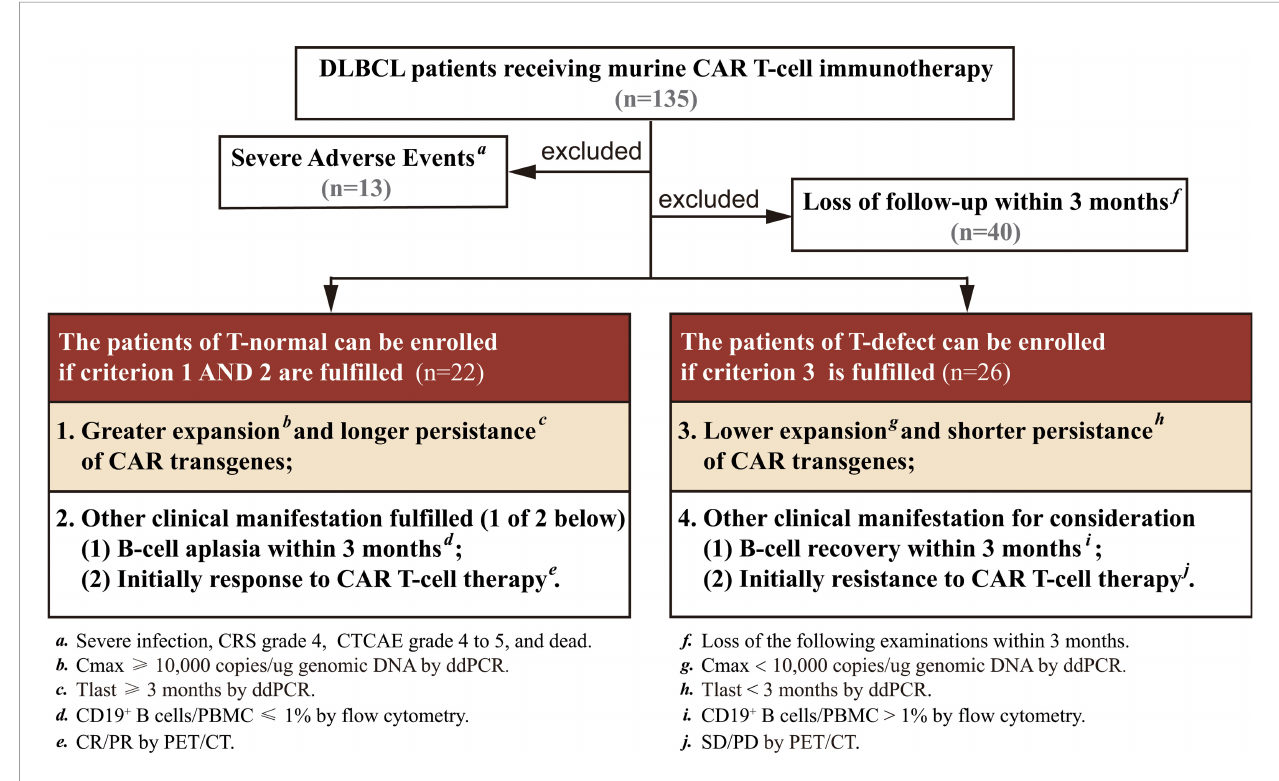
FIGURE 1 | Flow diagram summarizing patient recruitment, exclusion criteria, and patient groups. Patients were divided into a T-normal group (n=22) and T-defect group (n=26) according to the criteria of CAR transgene expansion, persistence, BCA, and initial response to CAR T-cell therapy. BCA, B-cell aplasia; CR, complete remission; CRS, cytokine release syndrome; CTCAE, common terminology criteria adverse events; ddPCR, droplet digital PCR; PET/CT, positron emission tomography-computed tomography; PR, partial remission; SD, stable disease; PD, disease